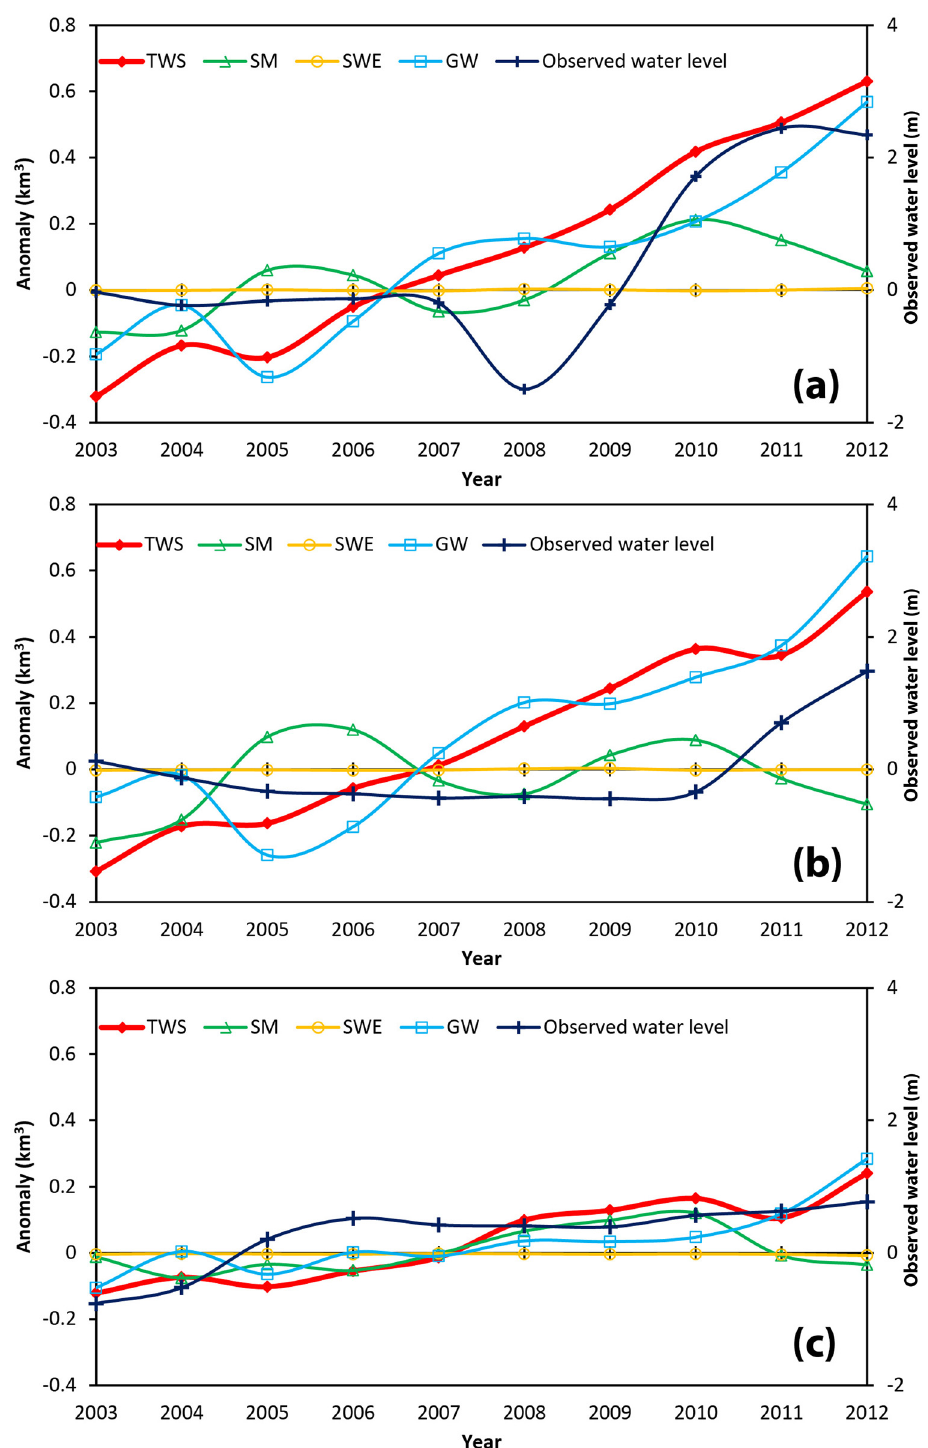
Fig 4. Changes of the TWS, its components, and observed groundwater levels in grids A (a), B (b), and C (c).